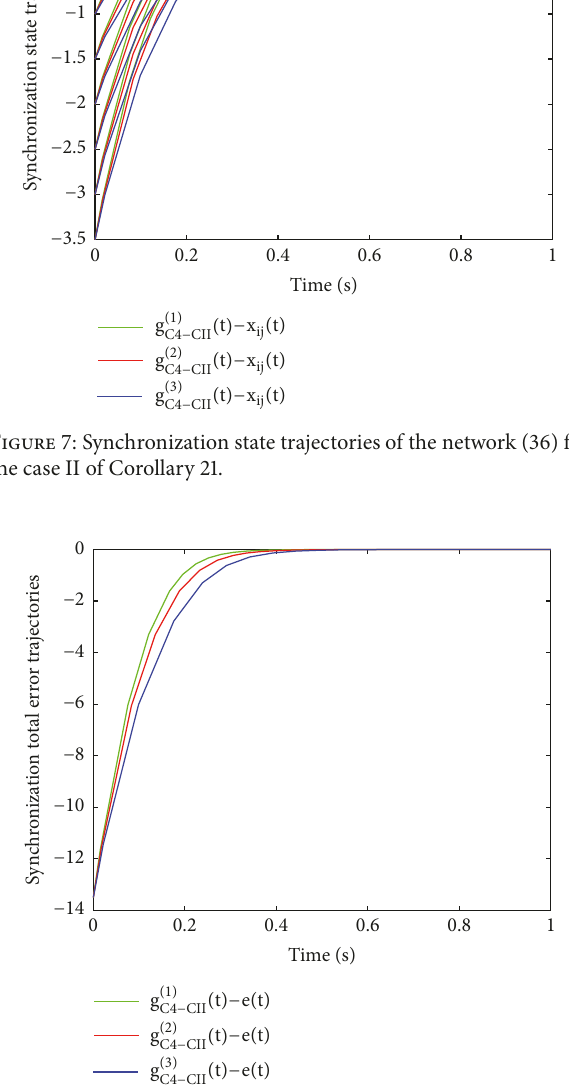
Figure 6: Synchronization total error trajectories of the network (36) for the case I of Corollary 21.